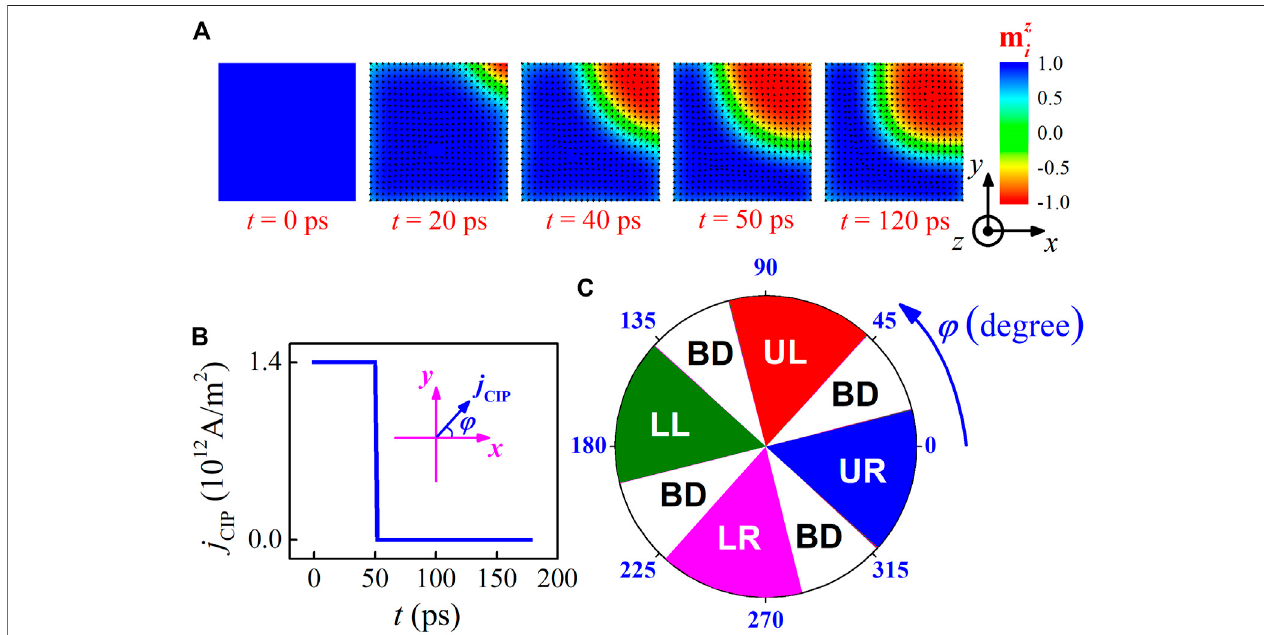
FIGURE 3 | The generation of kink from the initial ferromagnetic state, by injecting into the nanostructure an in-plane spin-polarized current pulse. (A) Snapshots show the formation process of the UR kink, driven by the current pulse with injection angle φ (cid:2) 10 ° . (B) A current pulse with current density j CIP (cid:2) 1.4 × 10 12 Am − 2 and duration t dur (cid:2) 50ps.TheinsertshowsthedirectionoftheCIPinjection,de fi nedbytheangle φ withrespecttothe x -axis. (C) Apiechartshowsfourcoloredsections,with thesectionscoloredred,green,pinkandbluerepresentingtheangleconditionsforgenerationofUL,LL,LR,andURkinks,respectively.Thewhiteregiononthepie chartcorrespondstoangleconditionsfortheformationofbubbledomain(abbreviatedto “ BD ” )likethatshownin Figure1A .Herethepiechartisgeneratedfromasetof data points for φ (cid:2) 2, 4, ... , 360 ° at intervals of 2 ° .